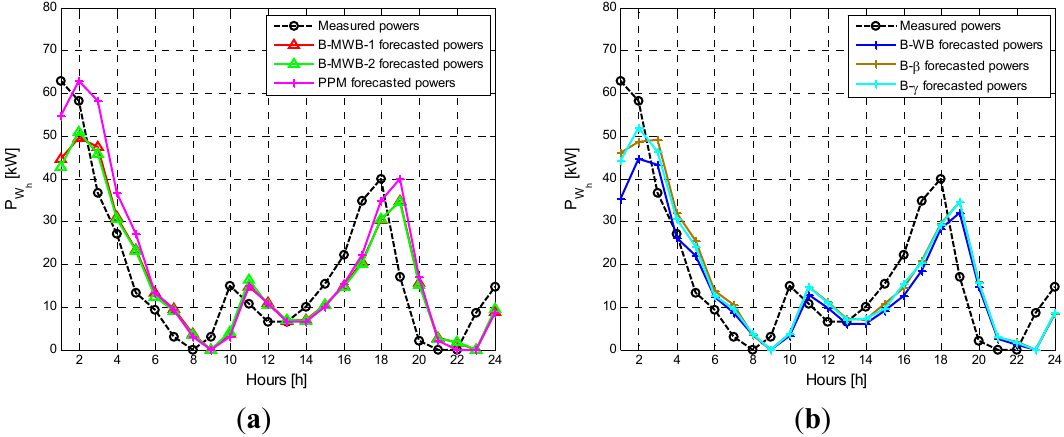
Figure 2. Spot value framework compared to the actual hourly wind power (dotted lines) (04/07/2013): ( a ) Proposed methods: B-MWB-1 and B-MWB-2 cases, and PPM; ( b ) Bayesian methods with unimodal distributions: B-WB, B- β and B- γ